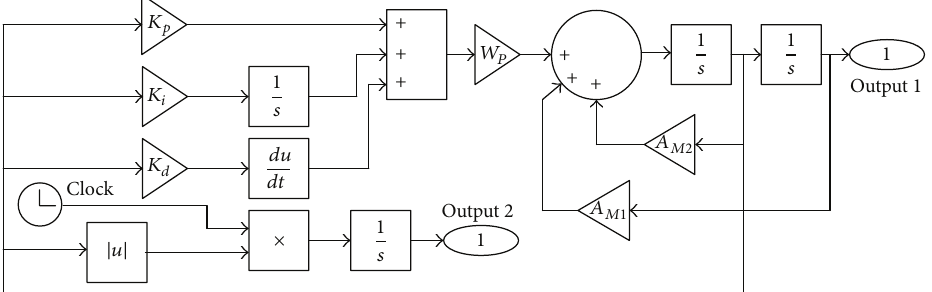
Figure 4: Block diagram of PID control strategy in